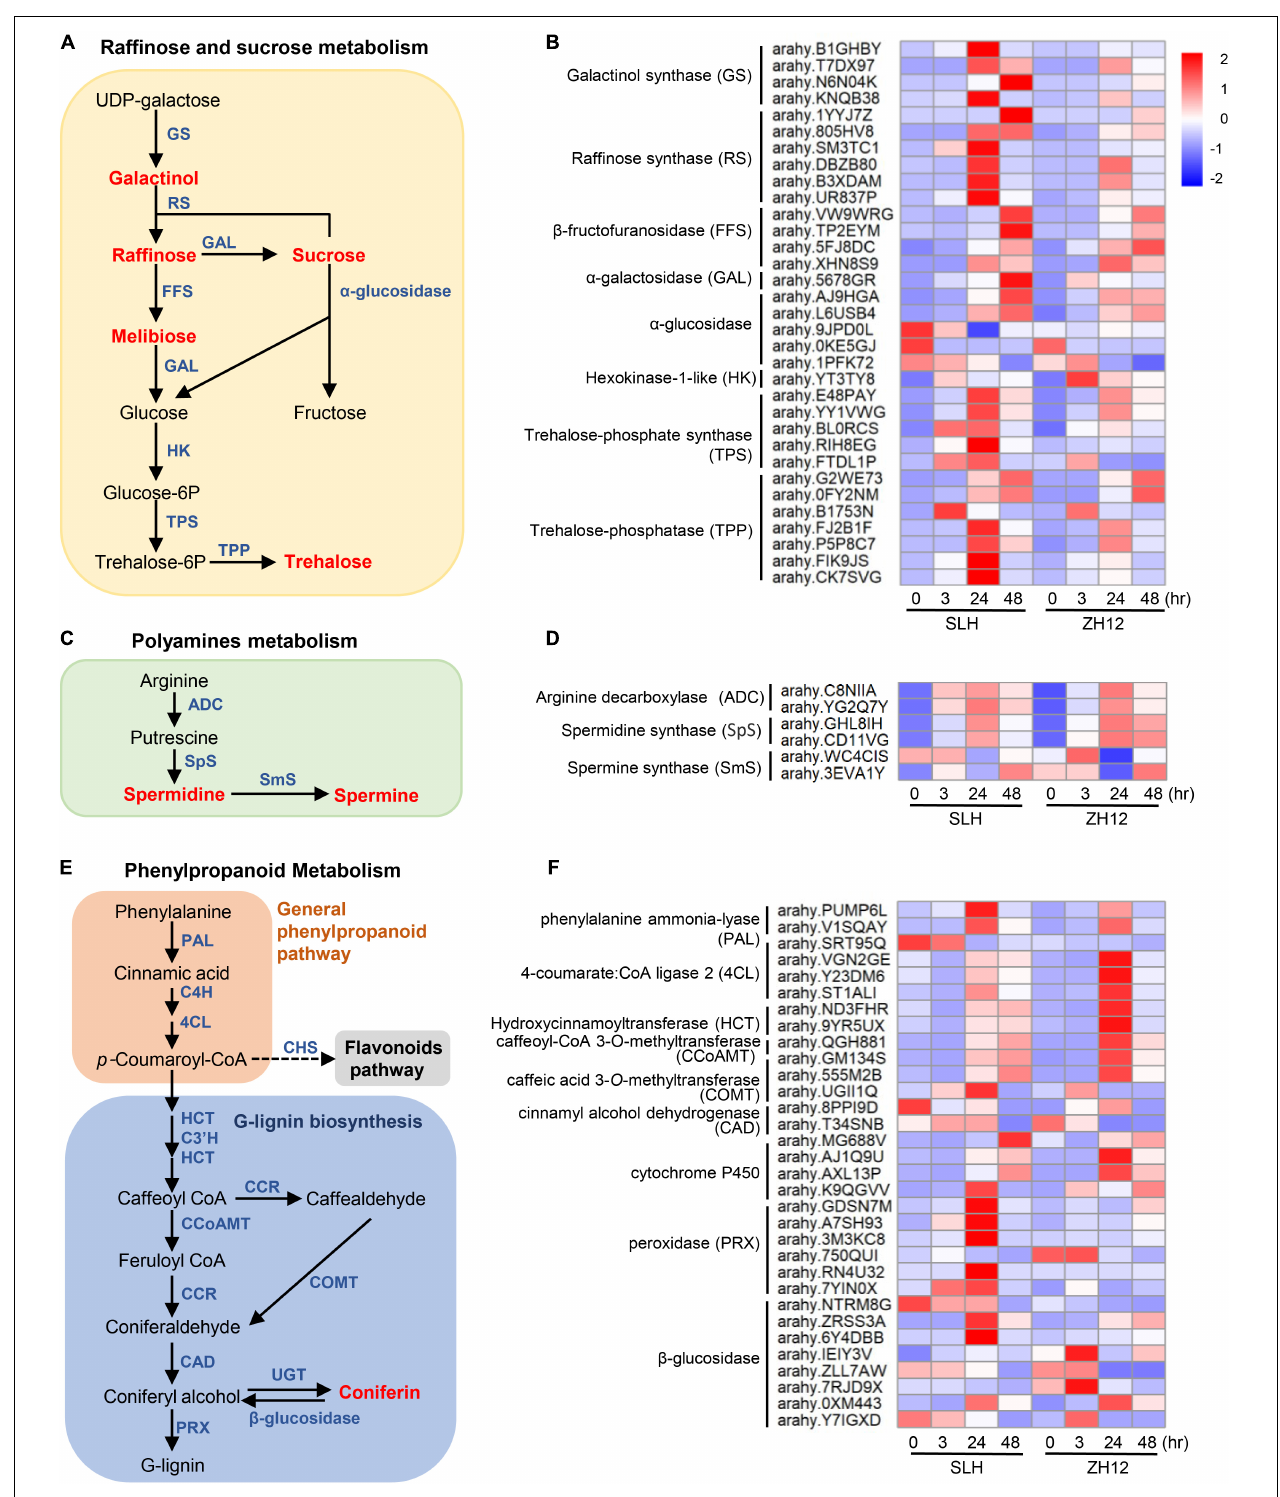
FIGURE 6 | Integrated analysis of metabolomic and transcriptomic profiles of peanut under cold stress. The schematic diagrams of raffinose and sucrose (A) , polyamines (C) , and phenylpropanoid (E) metabolism pathways. In the diagrams, the metabolites are marked by red, and structural enzymes are indicated by blue. The transcriptional patterns of several structural genes involved in the raffinose and sucrose (B) , polyamines (D) , and phenylpropanoid (F) metabolism pathway under cold stress. The heatmap values represent the Z-score of the FPKM (transcript levels) in different samples. Red color indicates a high expression level, while blue is